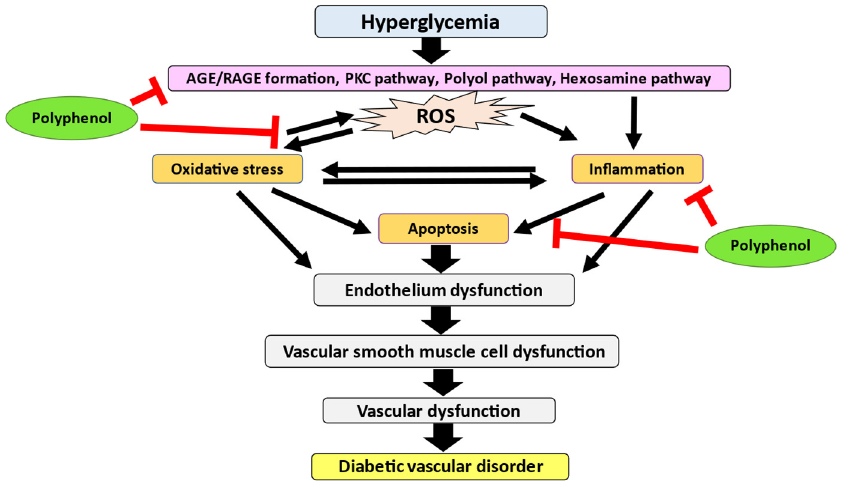
Figure 4. The capacity of polyphenols to resist DM-induced oxidative stress, inflammation, and apoptosis, all of which play critical roles in the structural and functional abnormalities in diabetic vascular disorder, indicates that they may alleviate the diabetic vascular disorder.